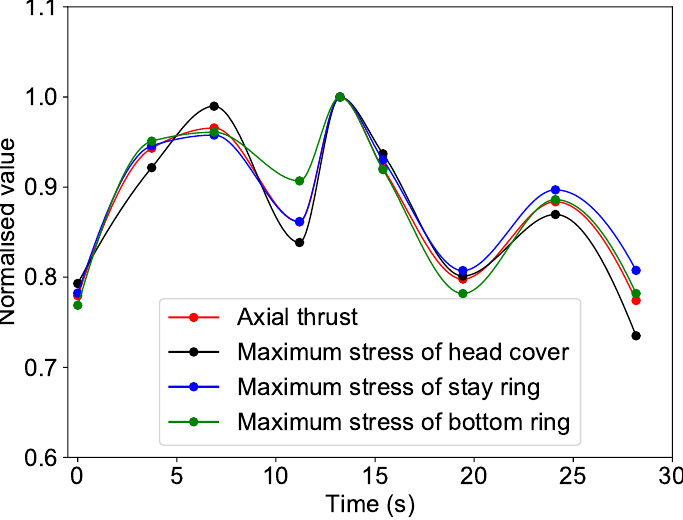
Figure 23. Results comparison of the PT unit during load